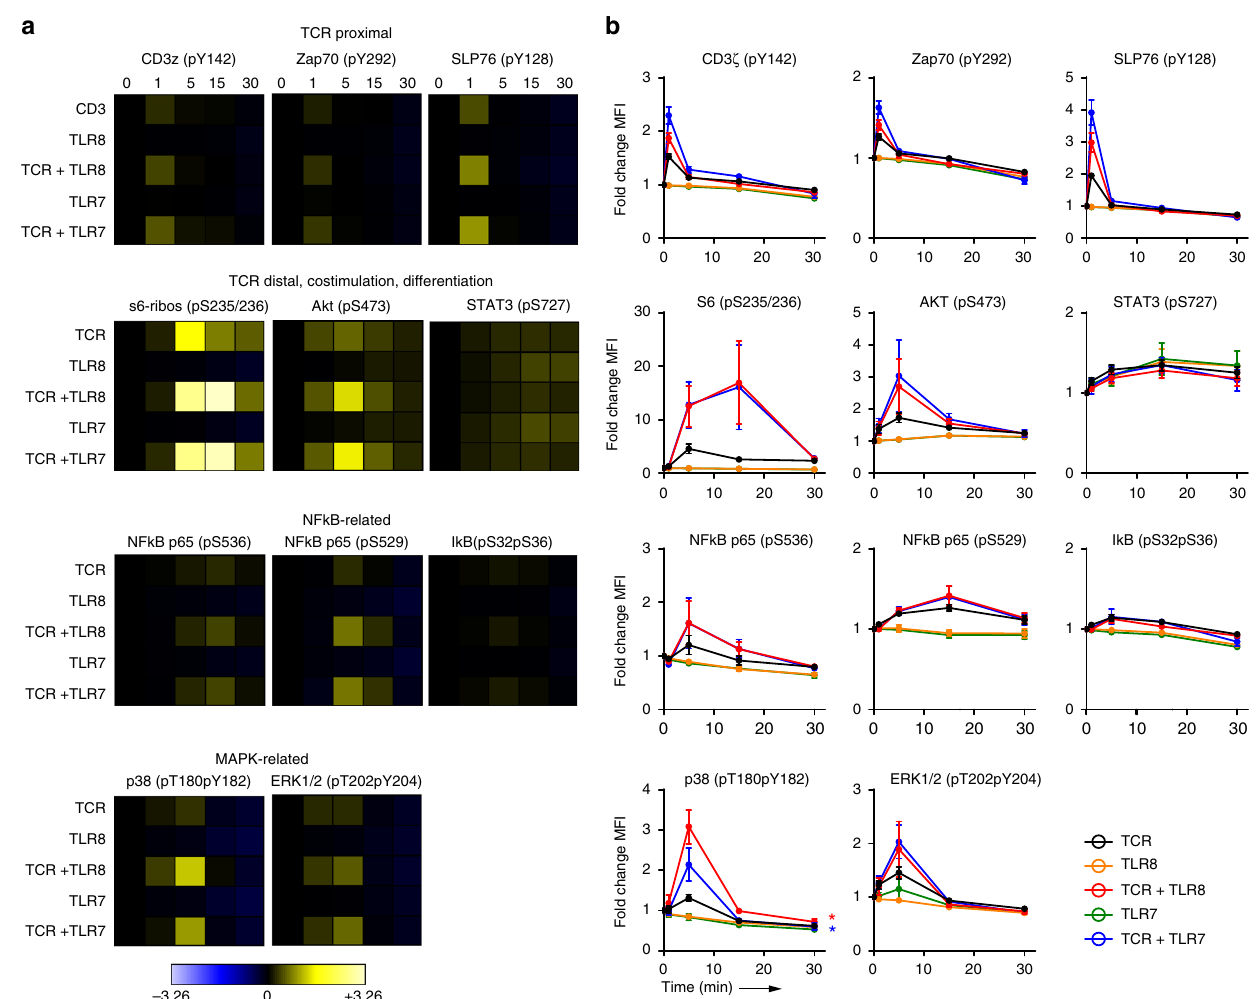
Fig. 4 TLR8 and TLR7 augment TCR signaling in CD4 + T cells. TCR signaling was induced in CD4 + T cells for 0 – 30 min in the presence or absence of 5 μ g/ml of CL264 (TLR7), CL75 (TLR8), or both. Phosphorylation of signaling proteins in the TCR and TLR pathways was analyzed using phospho-epitope- speci fi c antibodies. TCR proximal (CD3 ζ , Zap70, SLP76) and more distal (ribosomal protein S6, Akt, STAT3) signaling proteins were included, as well as proteins in the NF- κ B (p65, I κ B) and MAPK (p38, ERK1/2) pathways. Phosphorylation levels were quanti fi ed as arcsinh ratios of the median fl uorescence intensity for the various phospho-speci fi c Abs in activated versus unstimulated CD4 + T cells. a Phosphorylation levels displayed as heat maps (blue = reduced, yellow = increased) for one representative out of three experiments. b Phosphorylation levels from all three experiments displayed as the average arcsinh ratio± SEM of median fl uorescence intensities. Statistical signi fi cance was determined by area under the curve (AUC) calculation followed by one- way ANOVA with Dunnett ʼ s post-test on log-transformed data; signi fi cance levels: * p < 0.05; ** p < 0.01; *** p < 0.001. Source data are provided as a Source Data